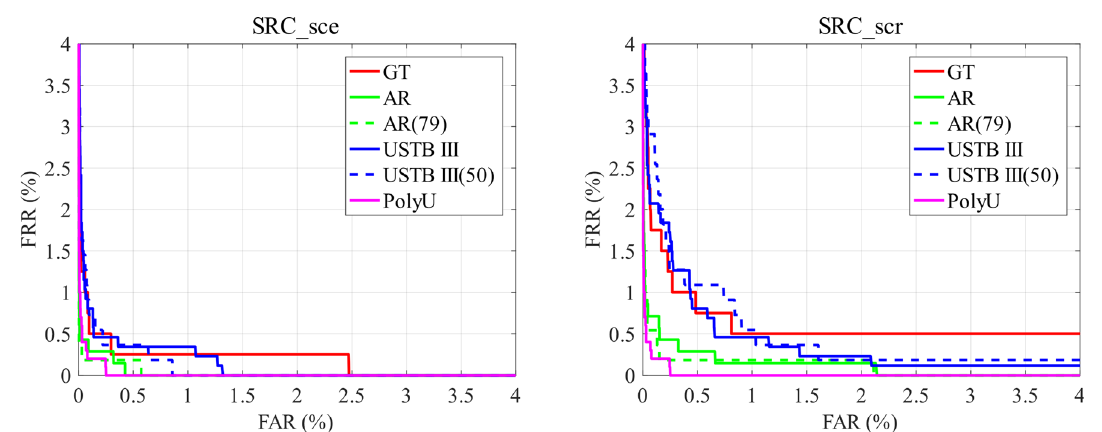
Fig. 10 The ROC curves of SRC-based unimodal verification with SCE and SCR when using CNN